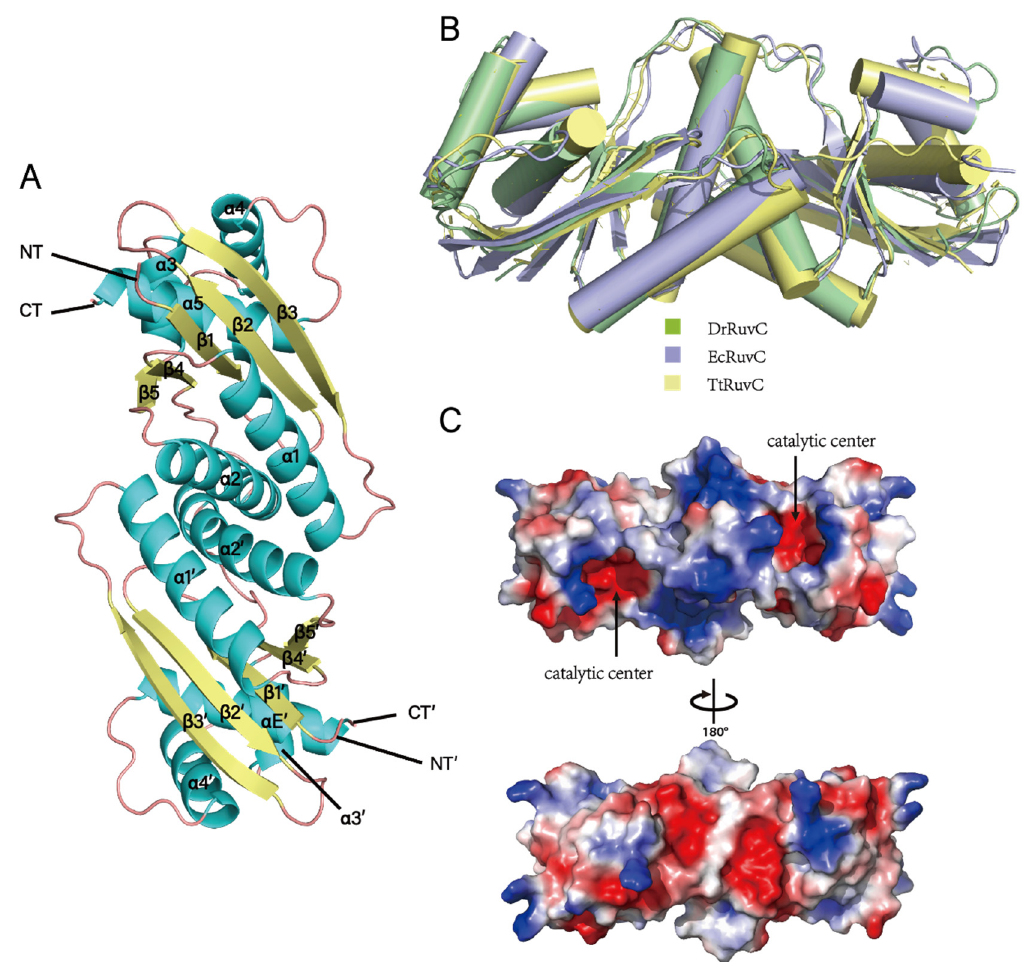
Figure 4. Crystal structure of Dr RuvC. ( A ) Cartoon diagram of the overall structure of Dr RuvC. The secondary structural elements are labeled. The N- and C-termini are indicated. ( B ) Structural superimposition of Dr RuvC with Ec RuvC and Tt RuvC. ( C ) Electrostatic surface of the Dr RuvC dimer colored according to the electrostatic surface potential (red: − 1 kT/e to blue: +1 kT/e), shown in two orientations rotated by 180 ◦ . The location of the active sites is indicated by